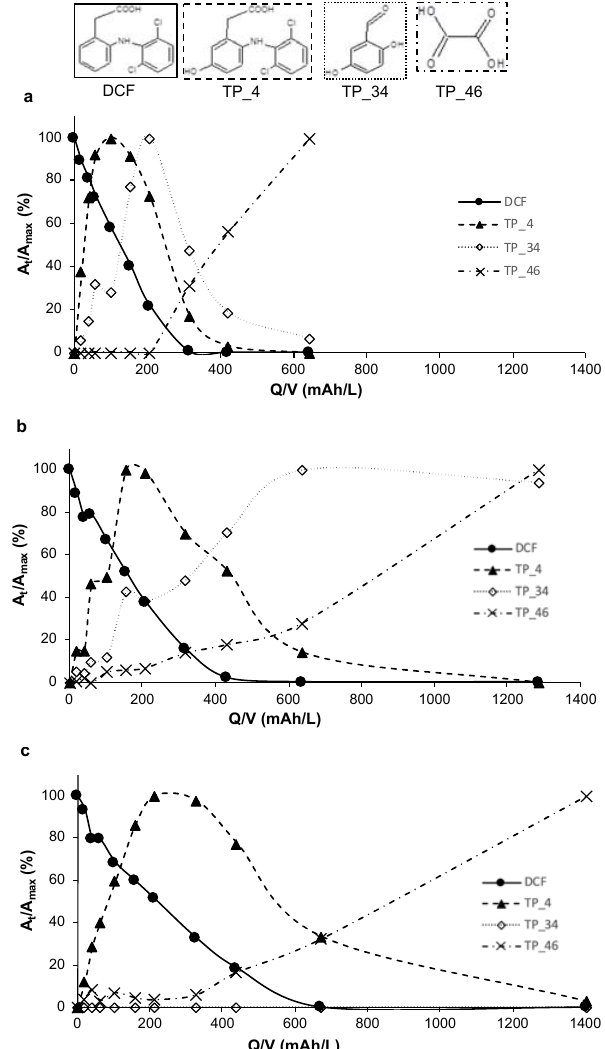
Figure 3. Formation and degradation of DCF TPs expressed as %-variation of the peak area of the respective EIC over the applied charge per volume (Q / V) in deionized water ( a ), drinking water ( b ), and wastewater effluent ( c ) at 292 mA/cm 2 .